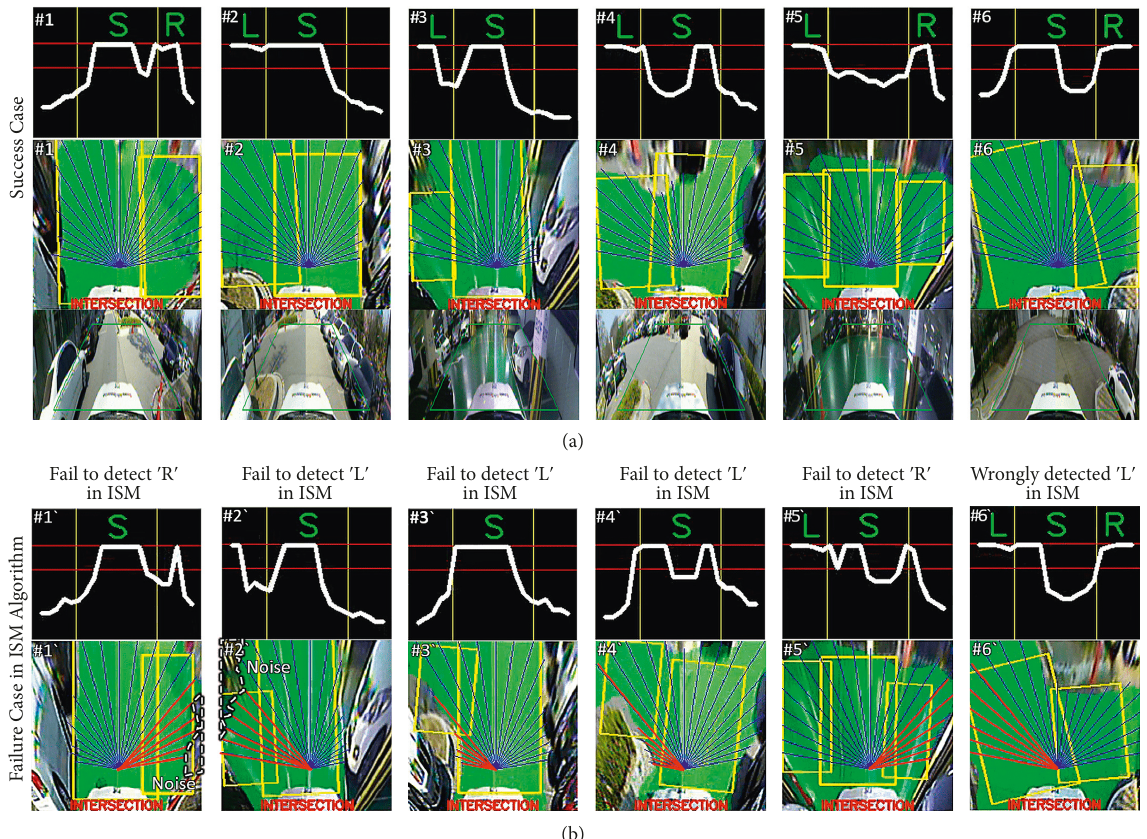
Figure 12: Branch road detection results at intersection; (a) and (b) are results of different ISM performances at different spots at the same intersection; (a) detection success case, (b) detection failure case in ISM algorithm